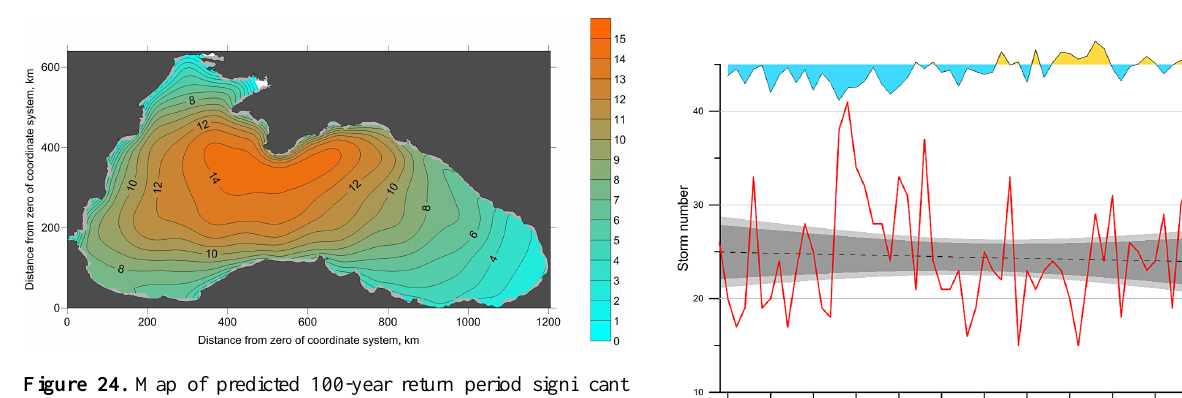
Figure 24. Map of predicted 100-year return period significant wave height [m].